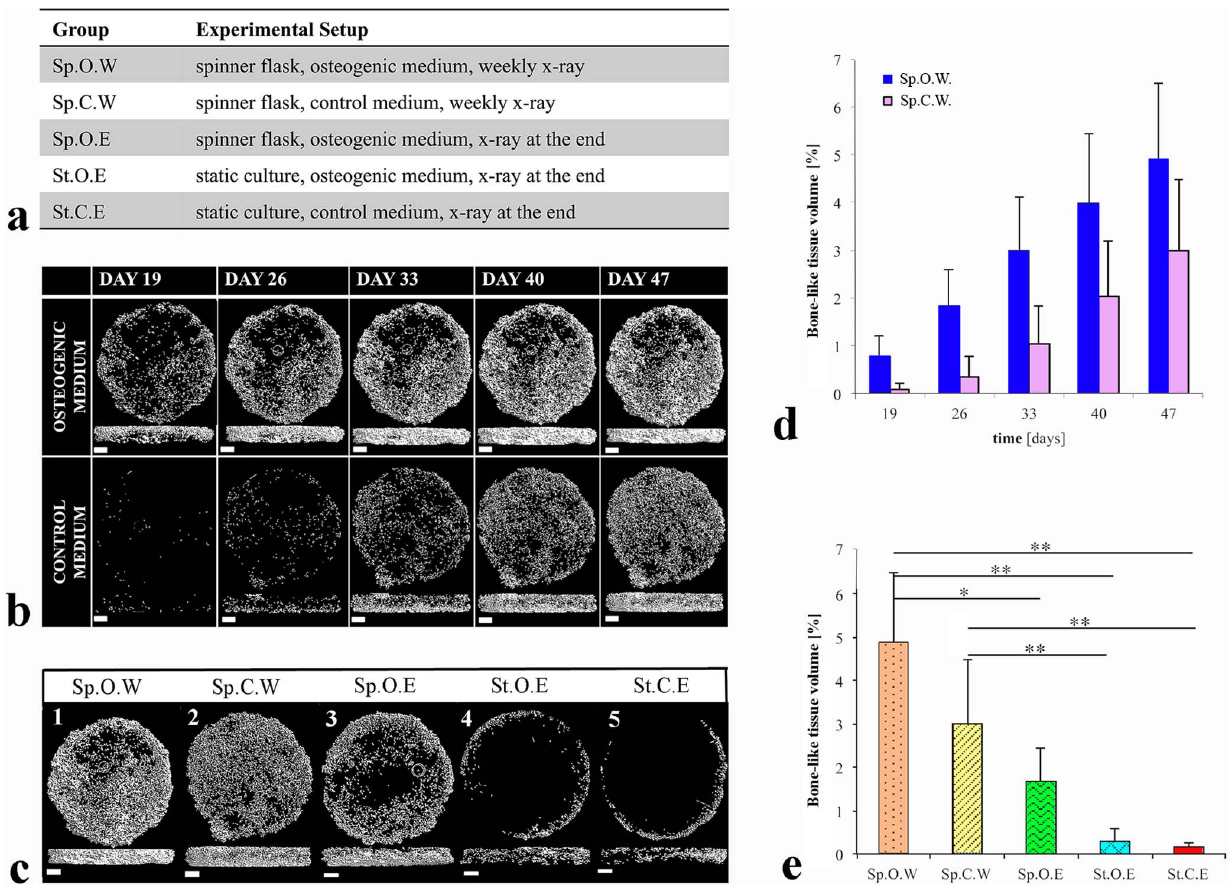
Figure 1. Mineralisation analysis using m CT. ( a ) Experimental groups. ( b ) Time-lapse m CT images of samples cultured in spinner flasks in either osteogenic (upper row) or control (lower row) medium. ( c ) m CT images of one representative sample per experimental group after 47 days of culture. ( d ) Time-dependent increase in bone-like tissue volume fraction as observed with weekly m CT scans. ( e ) Bone-like tissue volume fraction for all groups after 47 days of culture. Scale bars: 1 mm.